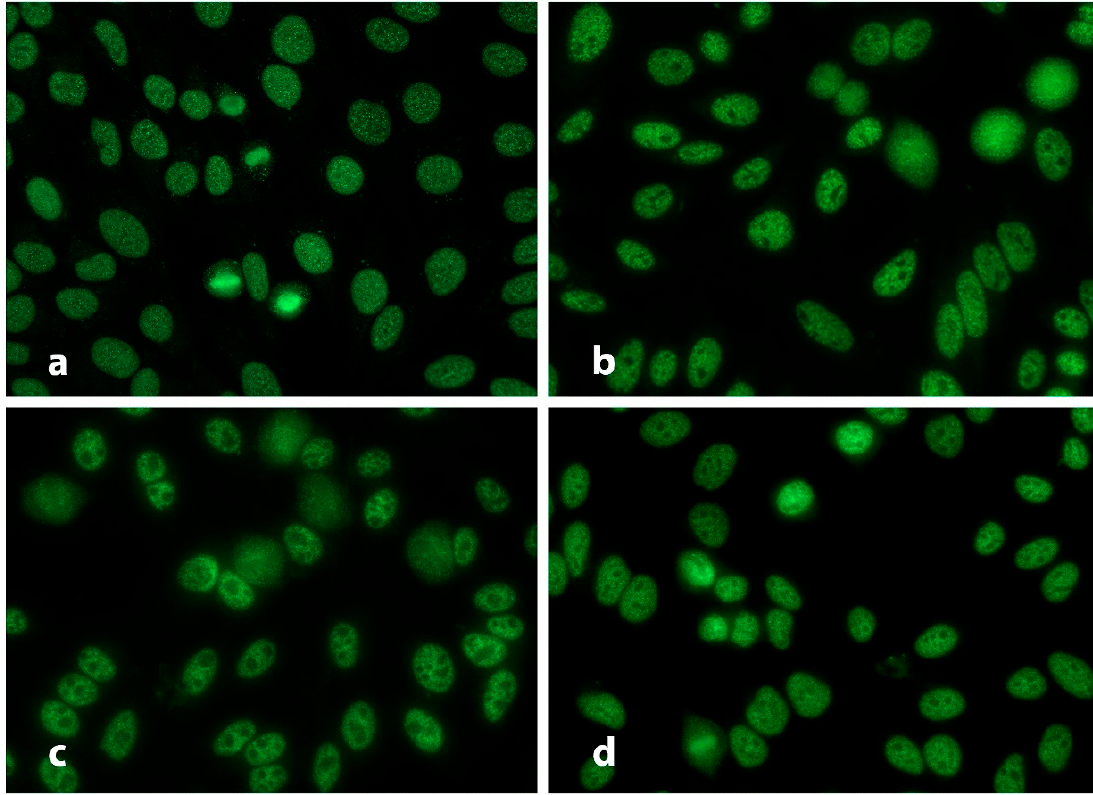
Figure 2. Anti-U11/U12 (RNPC-3) antibodies on HEp-2 substrates by indirect immunofluorescence (IIF) assay. Images of patterns derived from HEp-2 substrates from different manufacturers [( a ) Bio Rad; ( b ) Inova Diagnostics; ( c ) ImmunoConcepts HEp-2000; ( d ) Binding Site] using an index, monospecific human anti-U11/U12 (RNPC-3) antibody positive serum display fine discrete speckled